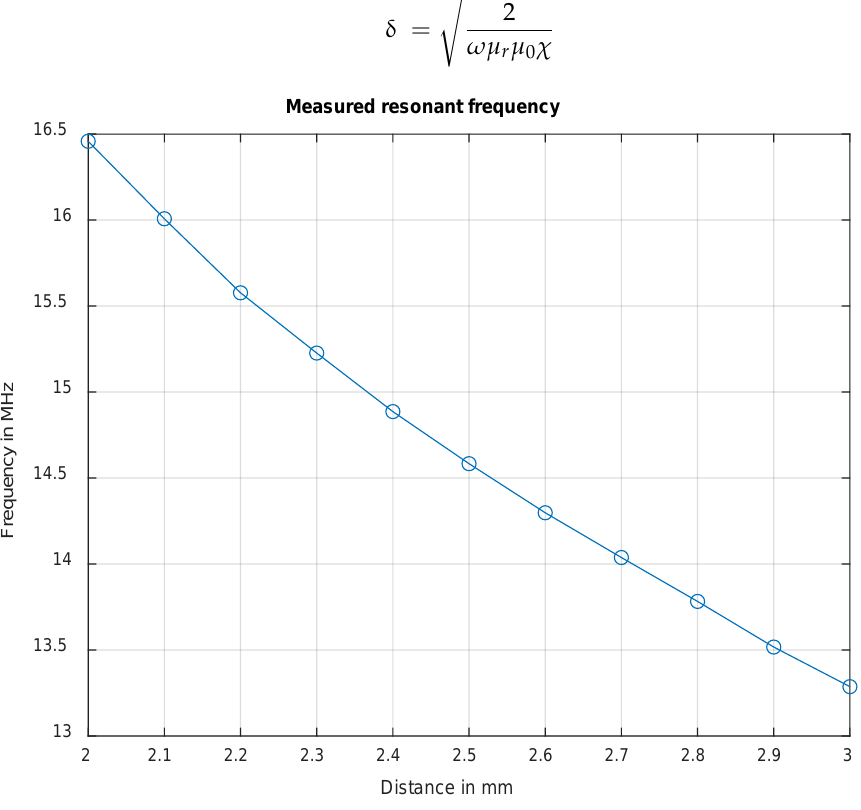
Figure 7. Measured frequency of the resonant circuit for distances between 2–3 mm.